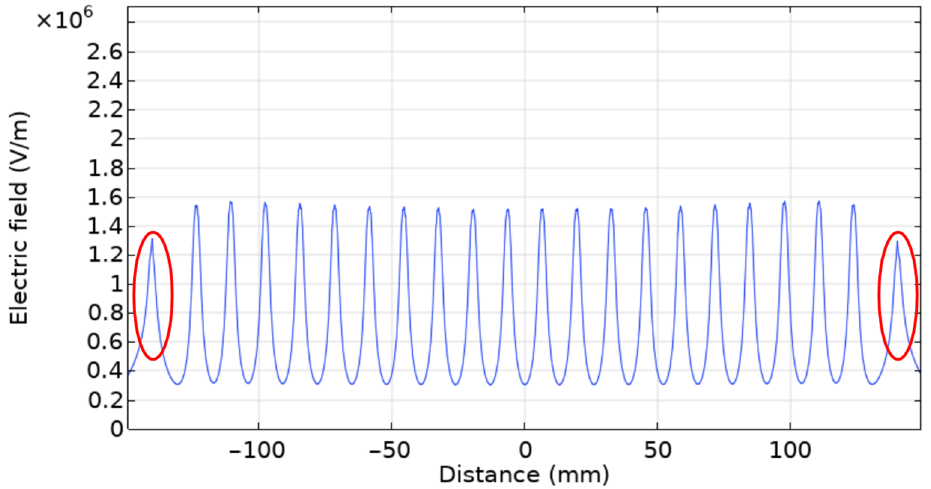
Figure 13. COMSOL electric field simulation with auxiliary electrodes, where the peaks correspond- ing to the parallel plates auxiliary electrodes are shown within the red circles.